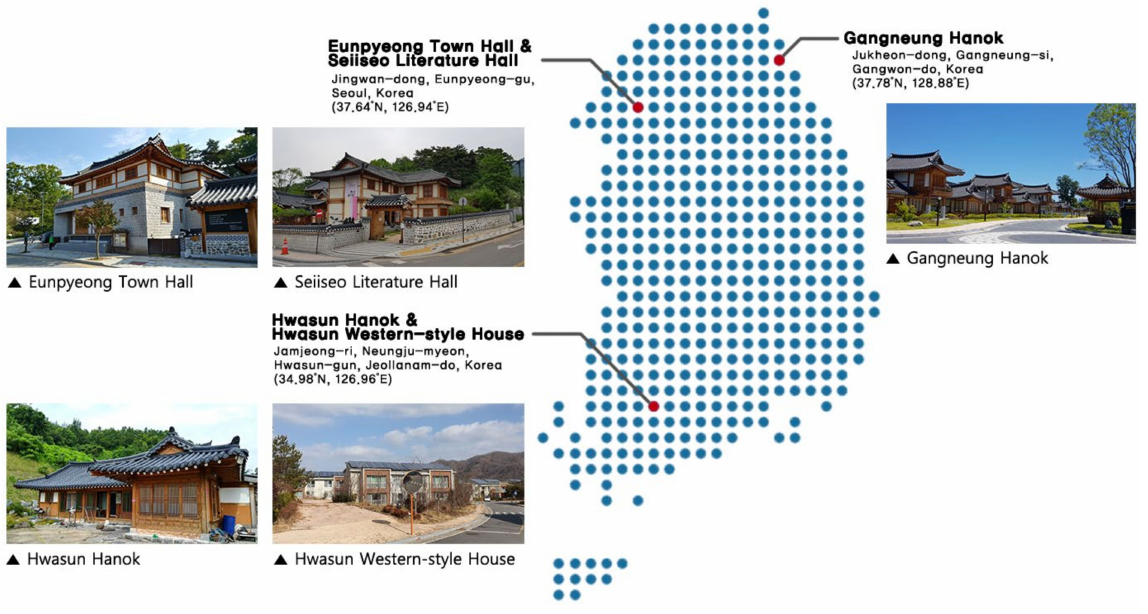
Figure 1. Evaluation place and location.